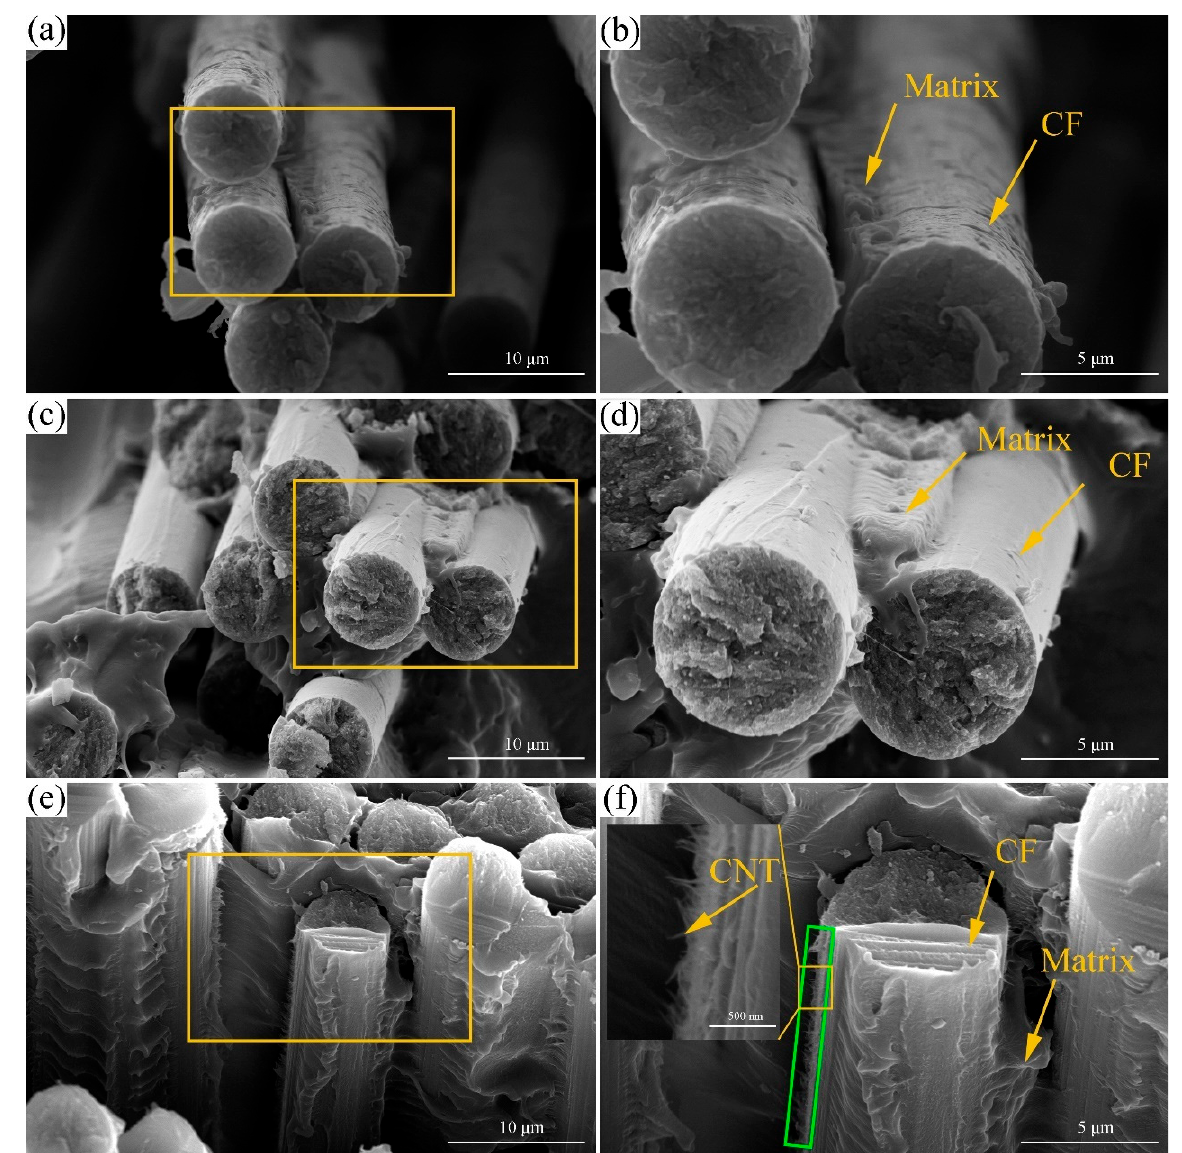
Figure 6. Microstructure of the fracture surface of the tensile specimen of the prepreg tape: ( a , b ) (36 wt%) CCF/PET, ( c , d ) (56 wt%) CCF/PET, ( e , f ) (1.0 wt%) CNT/(56 wt%) CCF/PET.